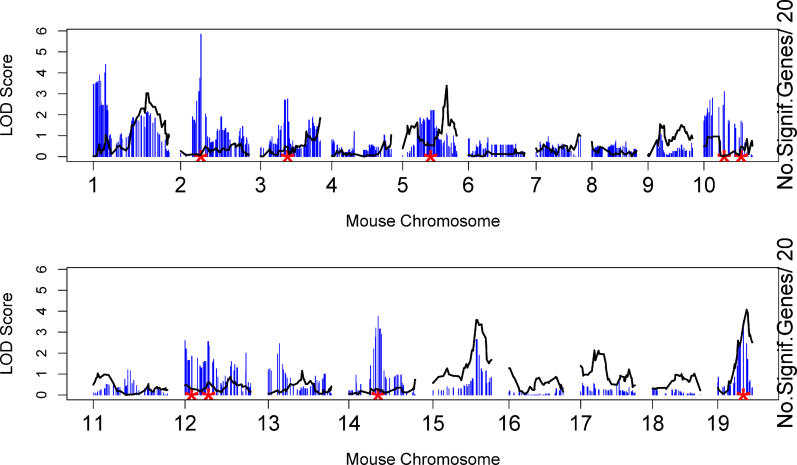
Blue Module mQTL Profile Partially Overlaps with the Physiological Trait (Weight) QTLThe black curves represent the QTL analysis across the genome for mouse body weight using a single marker genome scan according to the LOD score scale to the right. Evidence of linkage for weight was found on Chromosome 1 (50.4 Mb, LOD = 3.03), Chromosome 5 (118.5 Mb, LOD = 3.39), Chromosome 15 (78.2 Mb, LOD = 3.58), and Chromosome 19 (50.4 Mb, LOD = 4.07). For each marker, the blue vertical line represents the number (divided by 20) of significant Blue module genes, i.e., the number of genes whose single-point LOD at this marker is bigger than 2. For example, there is a SNP marker on Chromosome 2 at which 117 Blue module genes have a LOD bigger than 2. The red stars denote the locations of the mQTLs reported in Table 1.